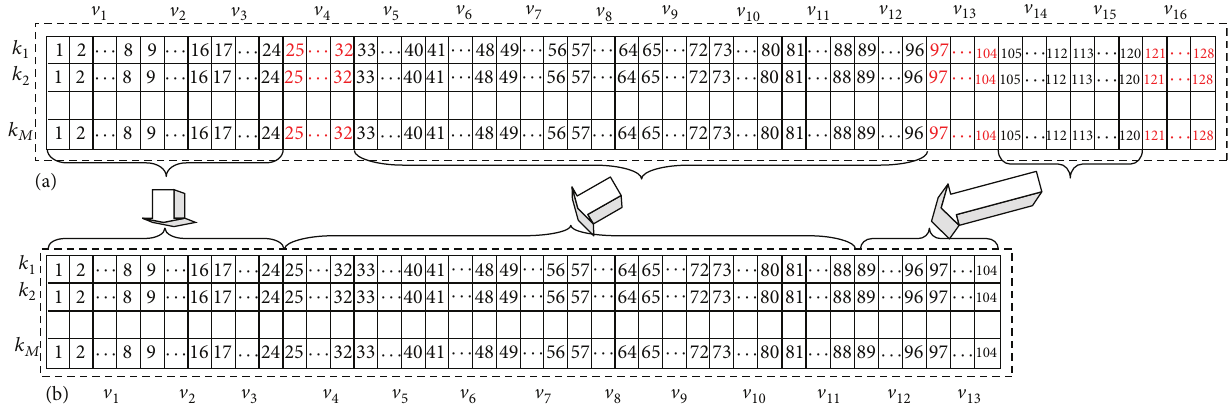
Figure 9: Illustration of feature elements selection based on magnitude. (a) Original feature matrix. (b) Discriminative feature matrix after feature selection based on neighborhood